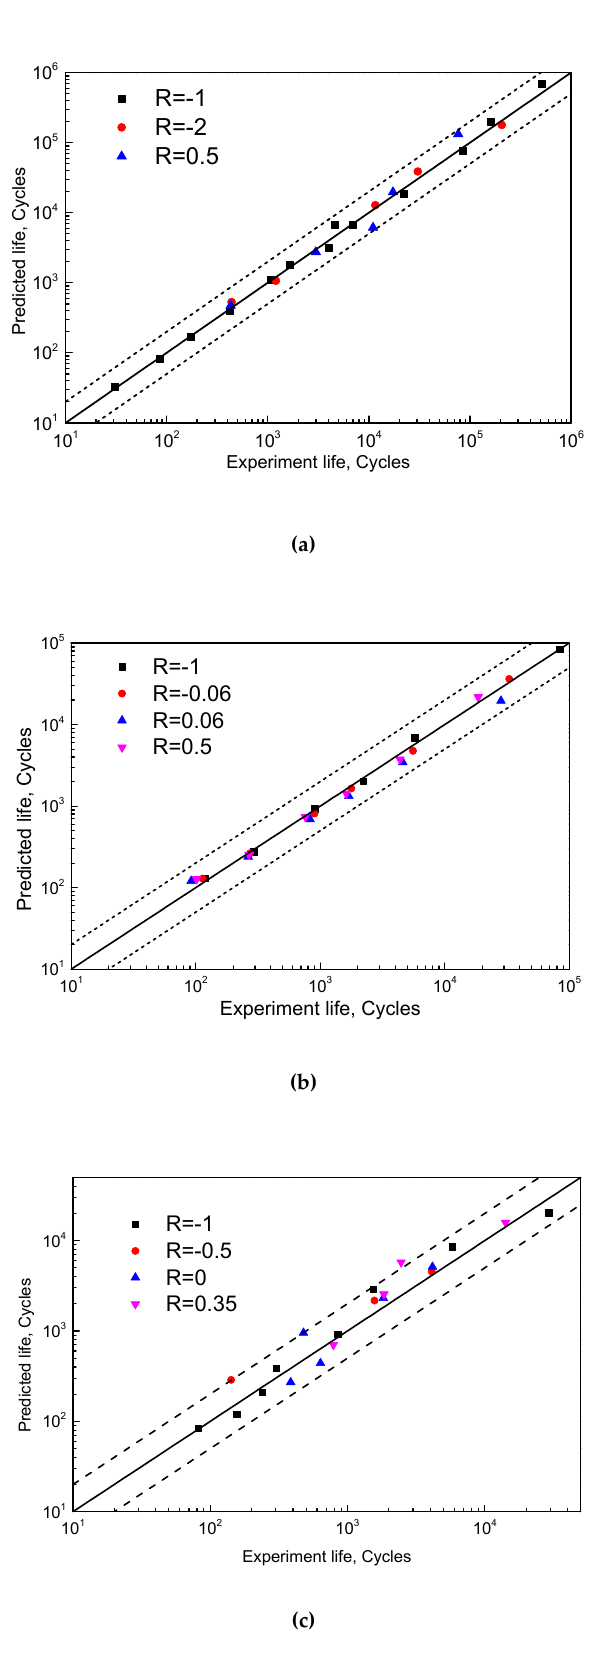
Figure 10. Prediction performance of proposed model for ( a ) HPTS, ( b ) T851 and ( c ) epoxy resin.